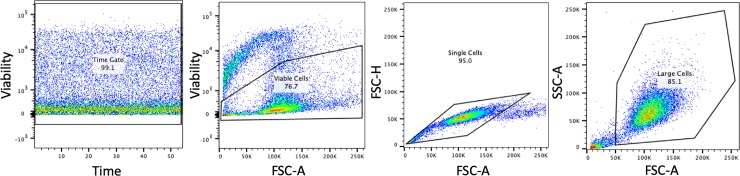
Gating scheme for MSC selection used in flow cytometry.Representative dot plots show the gating scheme that was used prior to quantification of MSCs positive and negative for the desired marker.